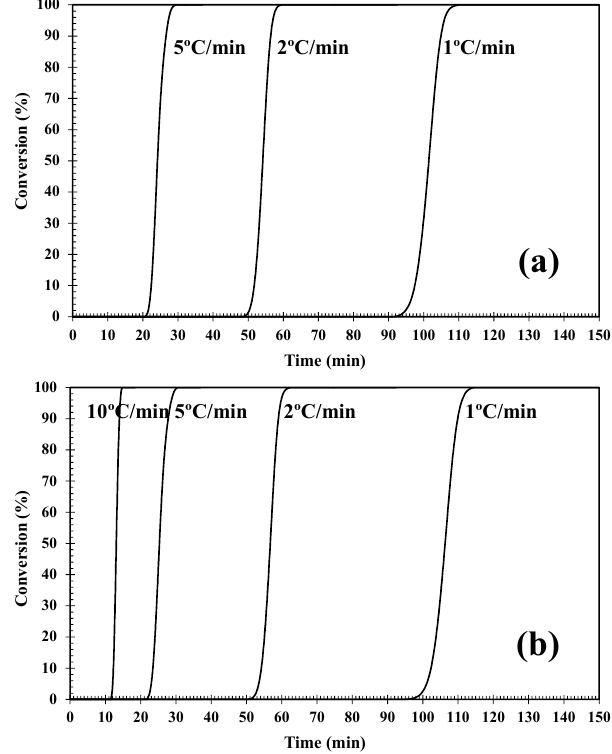
Figure 6. Plots of degree of conversion (x) vs. time for ( a ) PLLA and ( b ) PLLA / 2D-WS 2 (0.5 wt %) crystallized non-isothermally at various cooling rates.